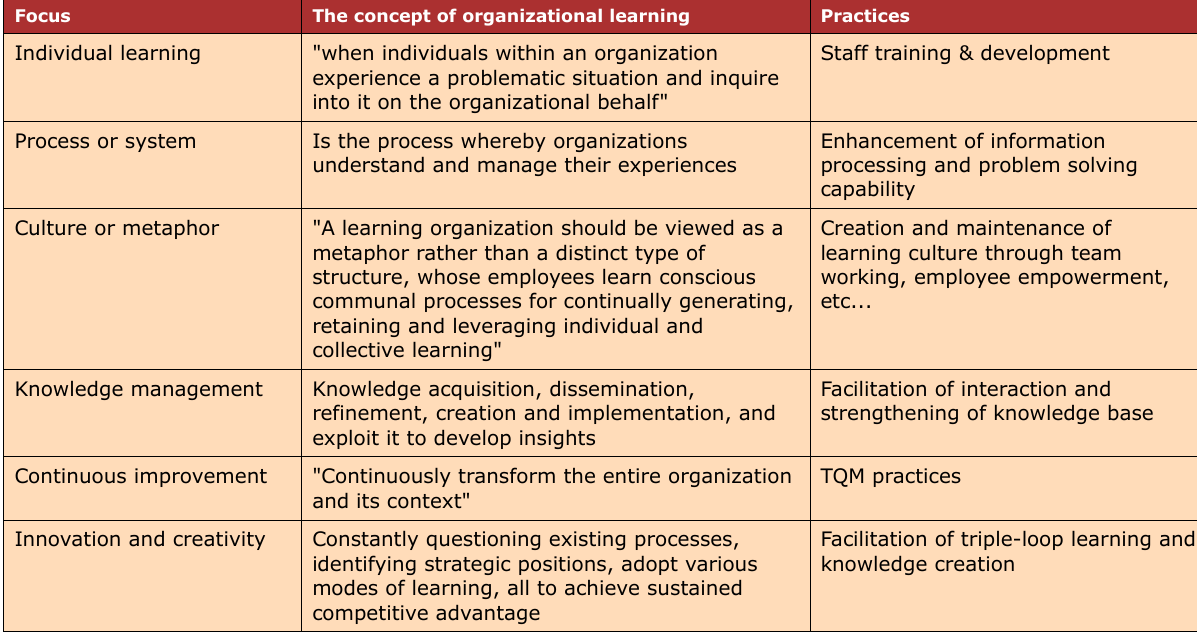
Table 1. Different forms of Organizational Learning (Wang & Ahmed,